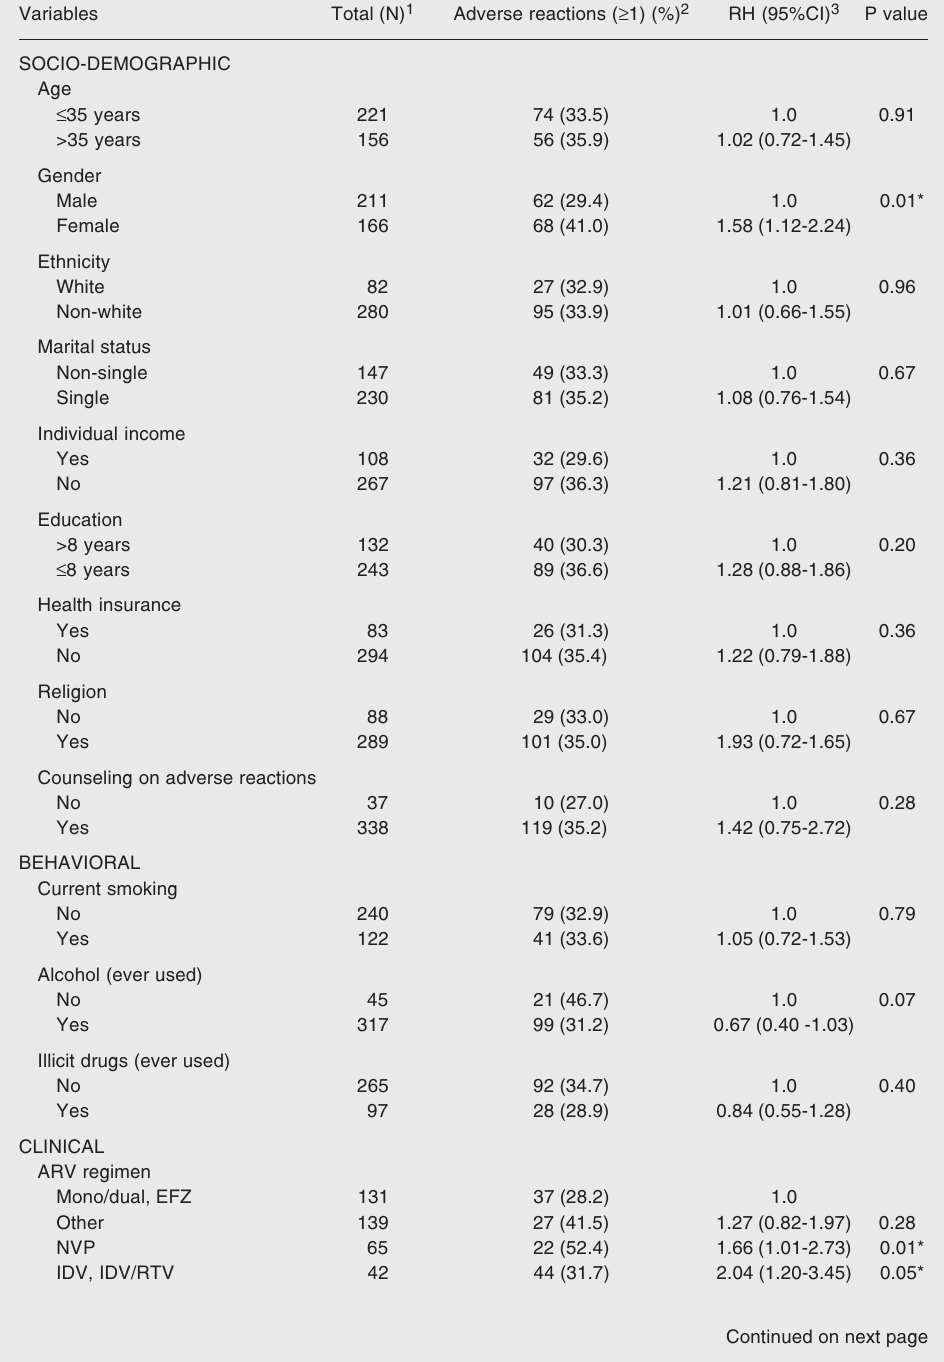
Table 3. Unadjusted analysis of adverse reactions to ARV according to socio-demographic, behavioral, clinical, and health care utilization variables, Belo Horizonte, MG, Brazil, 2001-2003 (N =